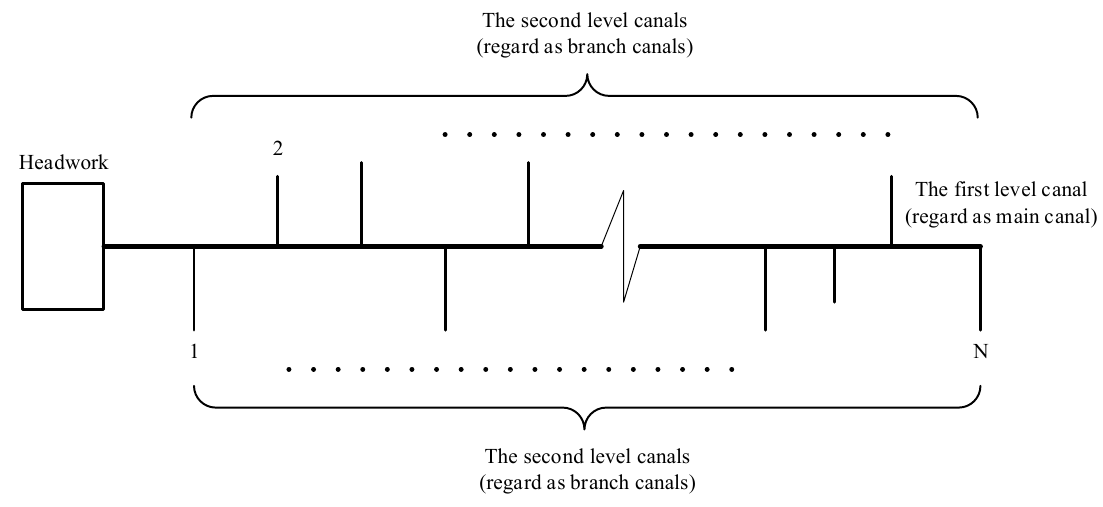
Figure 1. Schematic of a secondary irrigation canal system.